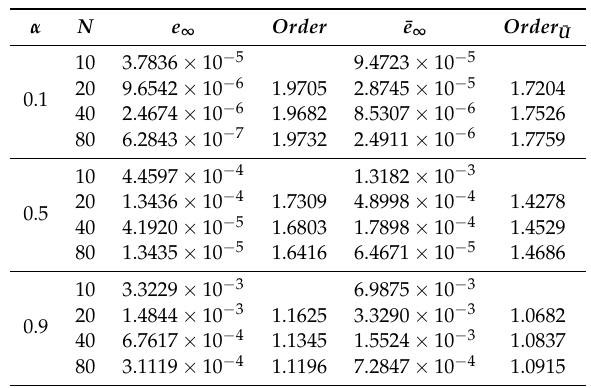
Table 2. e ∞ , ¯ e ∞ and convergence orders, related to the numerical solutions, U n for different values of N and α , with J =